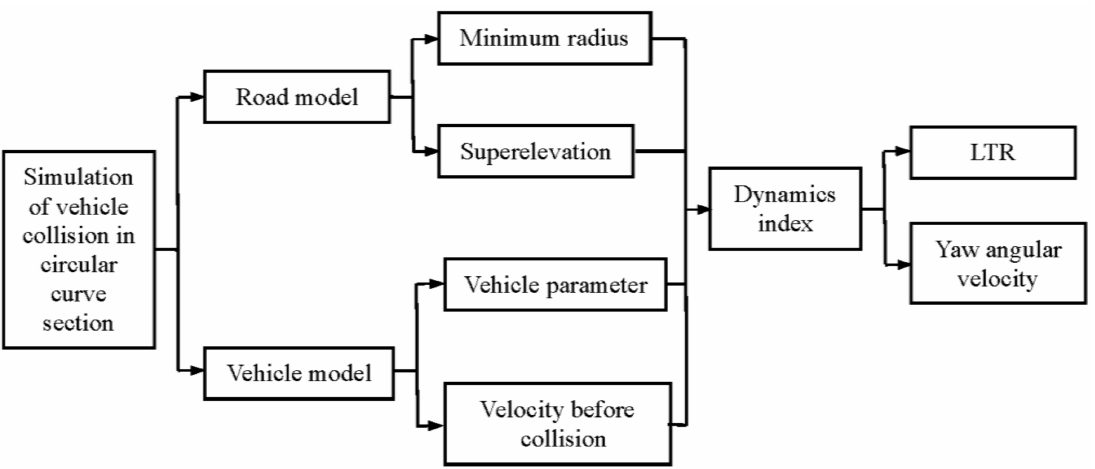
Figure 5. Vehicle collision simulation process.